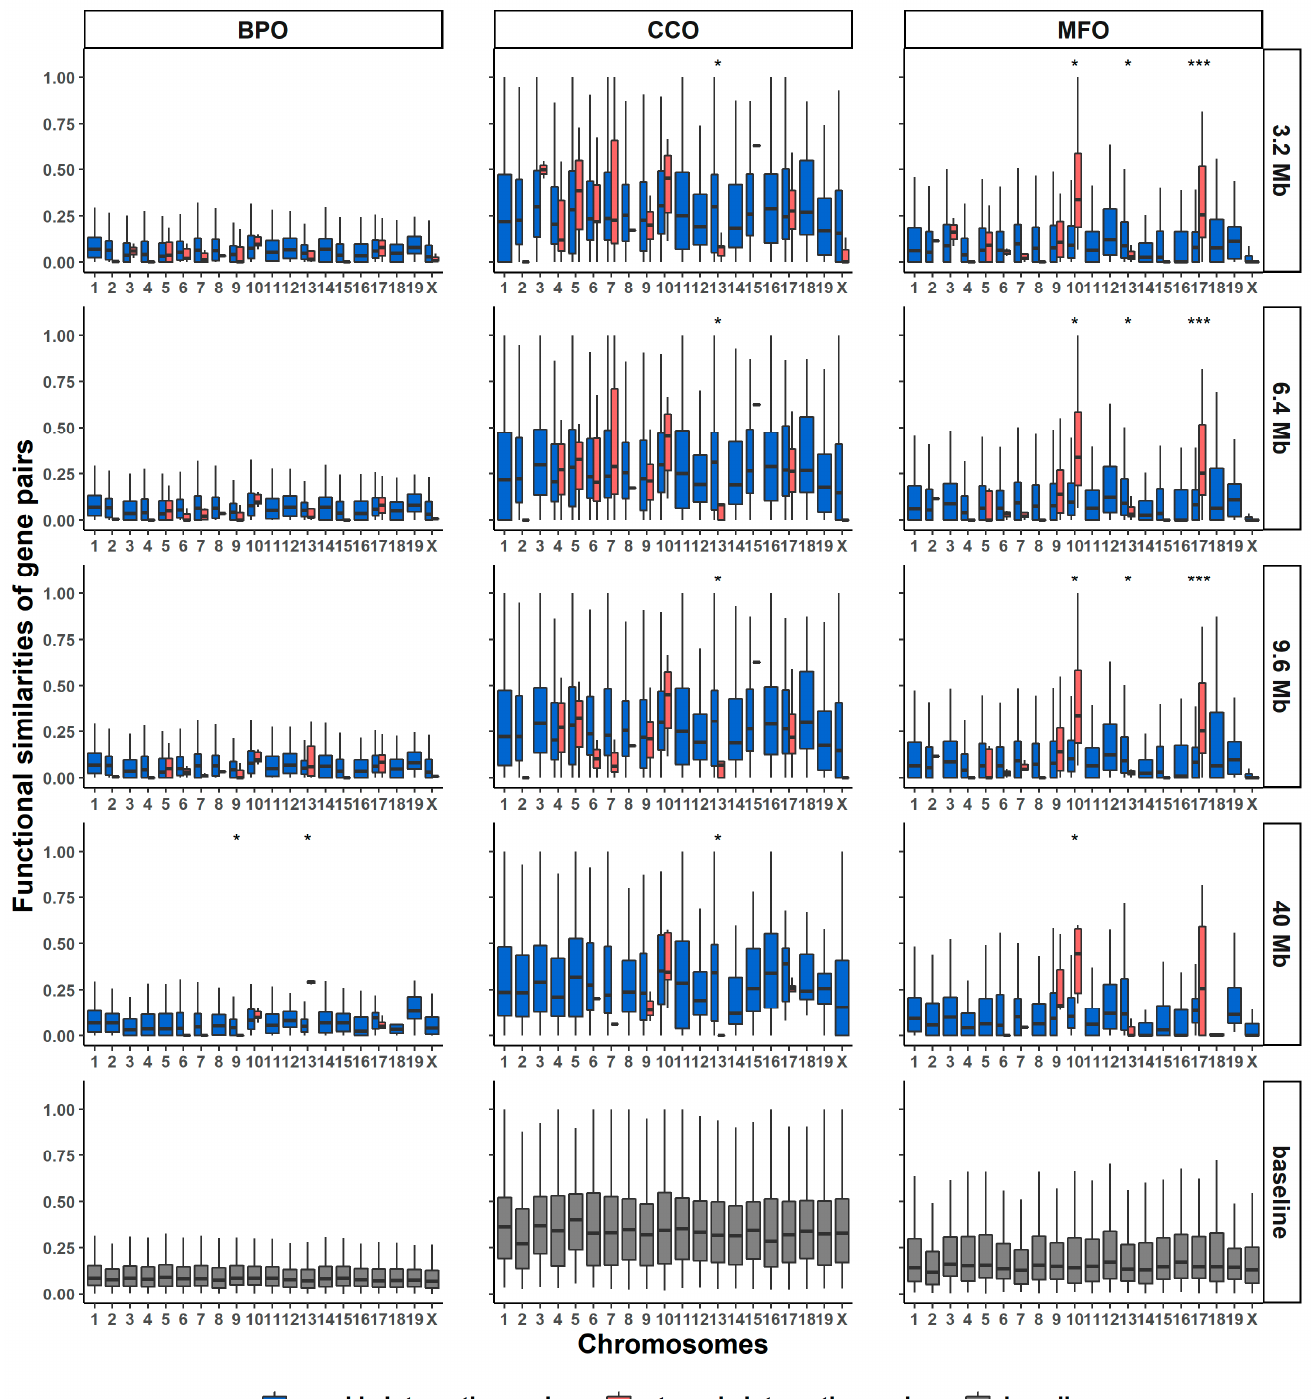
Figure 5. Boxplots of functional similarities of gene pairs from long-range interactive regions in BPO, CCO, and MFO. Different rows represent that the boxplots were generated at different genomic- distance thresholds: 3.2 Mbp, 6.4 Mbp, 9.6 Mbp, 40 Mbp, and baseline. The baseline gene pairs were randomly selected regardless of weakly or strongly interactive regions. *** indicates that the p -value of the Wilcoxon test is less than 0.0001, and * indicates that the p -value is between 0.001 and 0.05.